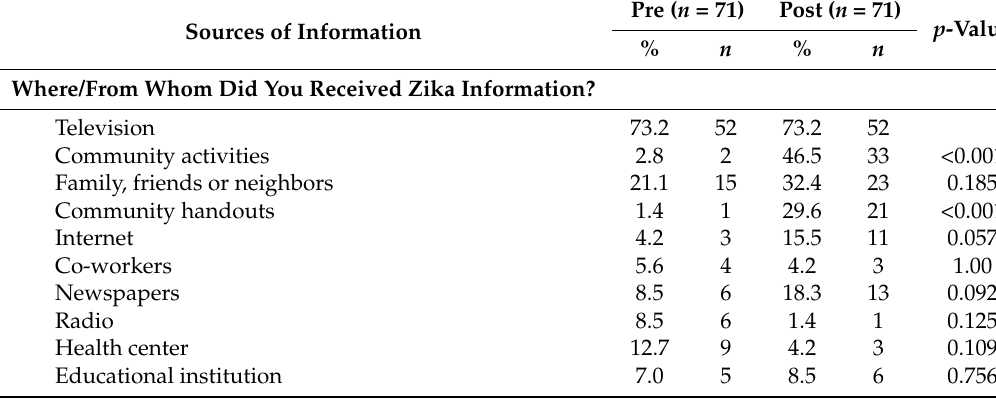
Reported sources from which respondents received information about Zika at pre and